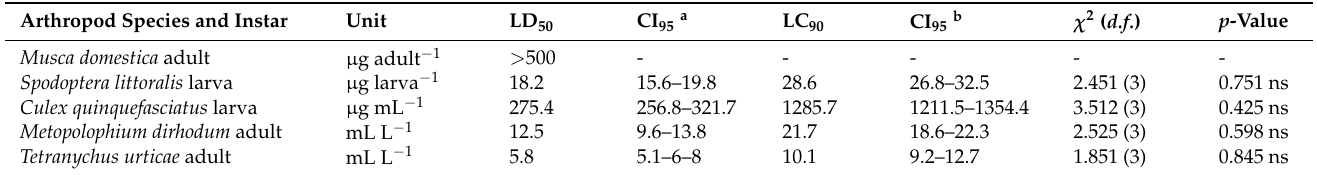
Table 3. Acute toxicity of the positive control, a commercial botanical insecticide based on Pongamia pinnata oil, on selected insect and mite